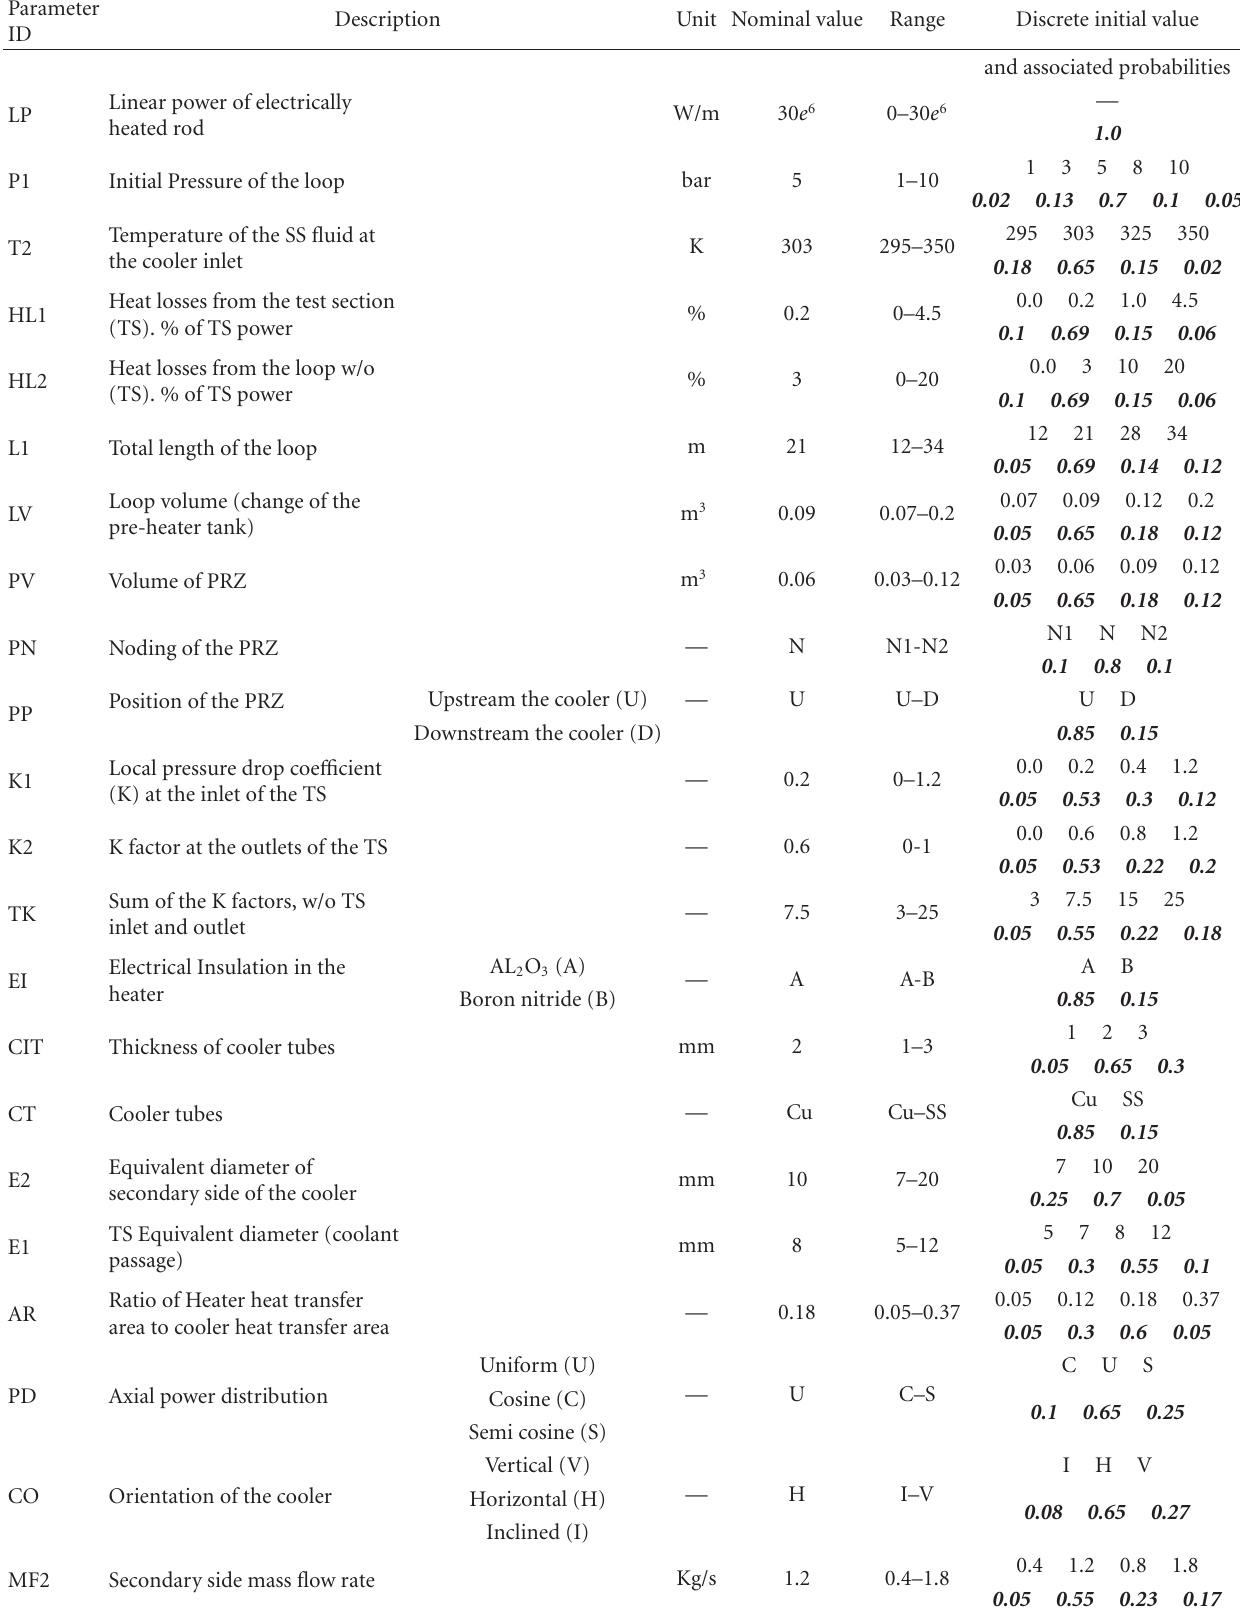
Table 5: Design and critical parameters case